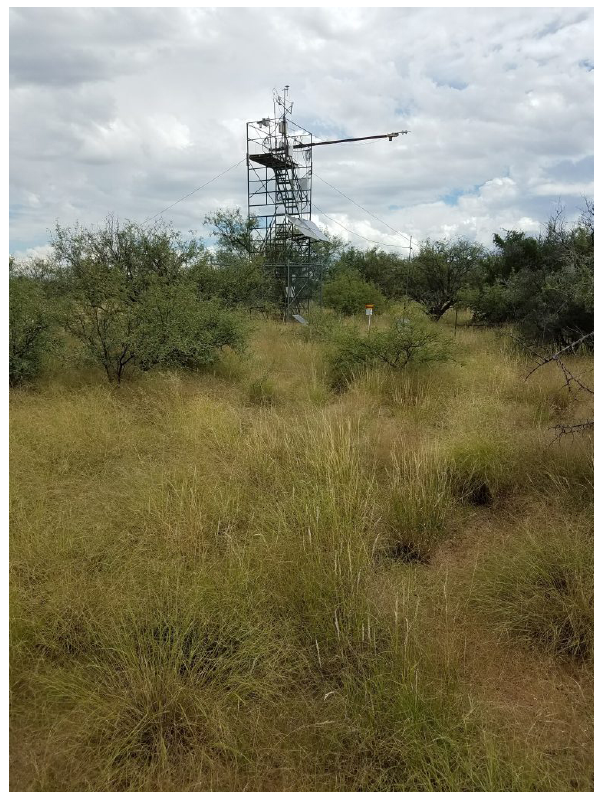
Figure 4. Semidesert grassland encroached by mesquite ( Prosopis velutina ) at Santa Rita, Arizona (US-SRM). Image credit: Russell Scott, 9 December